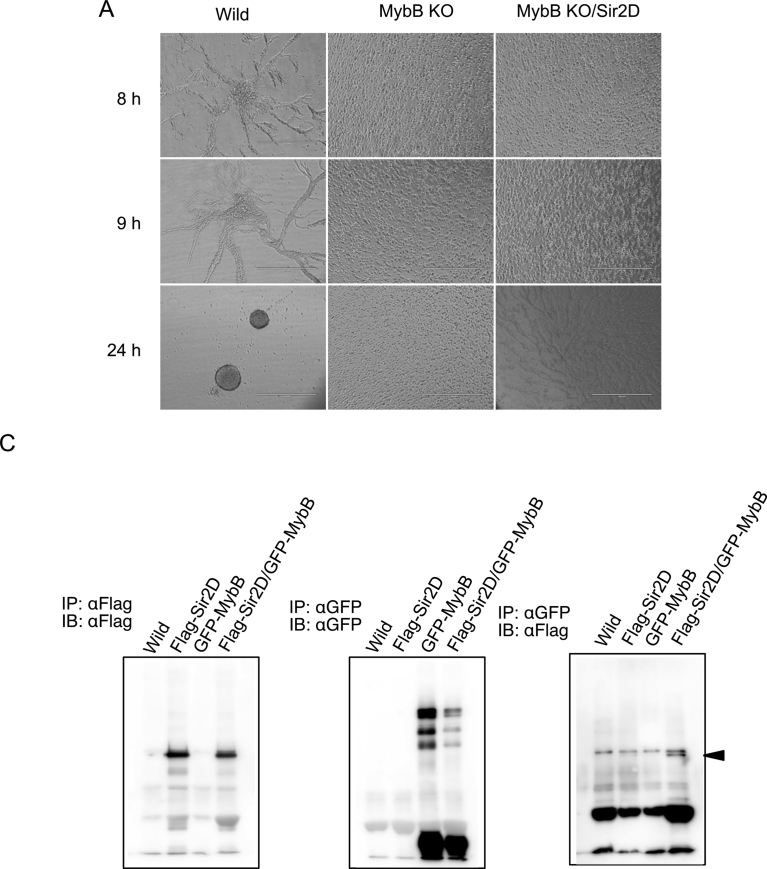
Supplementary Fig. S6.eps